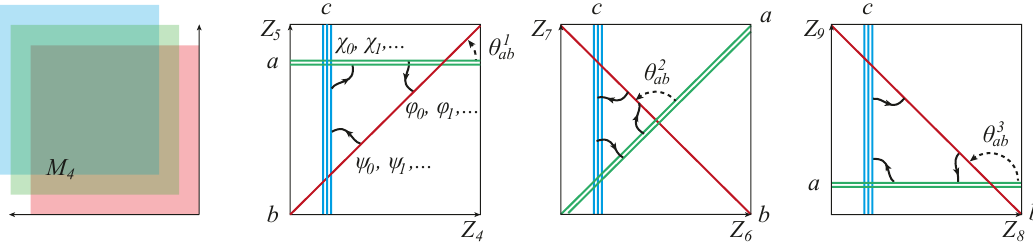
Figure 3 . Three stacks of branes spanning 4-dimensional Minkowski space and intersecting in the T 2 T 2 internal manifold T 6 = T 2 1 2 × 3 . Each intersection has a massless zero mode, denoted with the × subscript 0 , and an infinite tower of massive states whose first mode is denoted with the subscript 1 . At a given intersection, the zero modes are the same in each 2 -tori, but the towers are different for each T 2 i